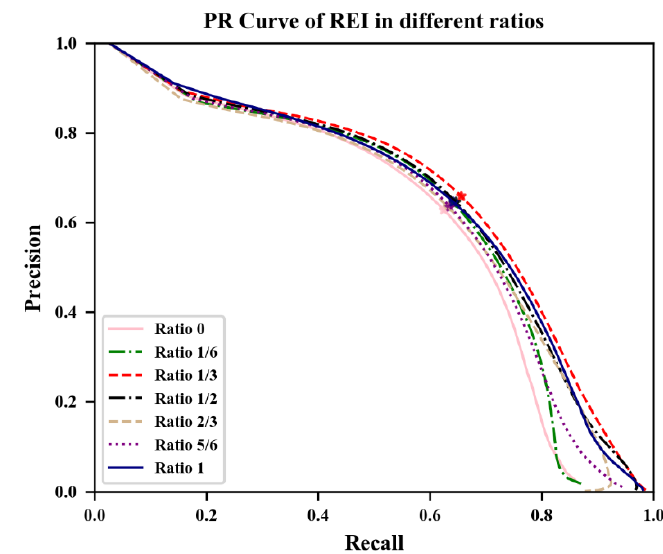
Figure 12. Precision-recall curve for different ratios on the test set.